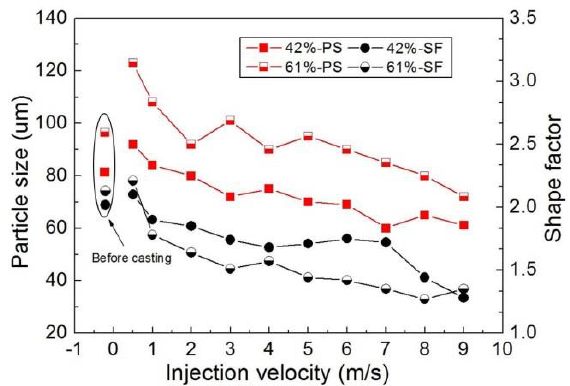
Figure 6. Effect of injection velocity on the particle size and the shape factor of primary α -Mg in rheo-diecast AZ31 alloy under different solid fractions.